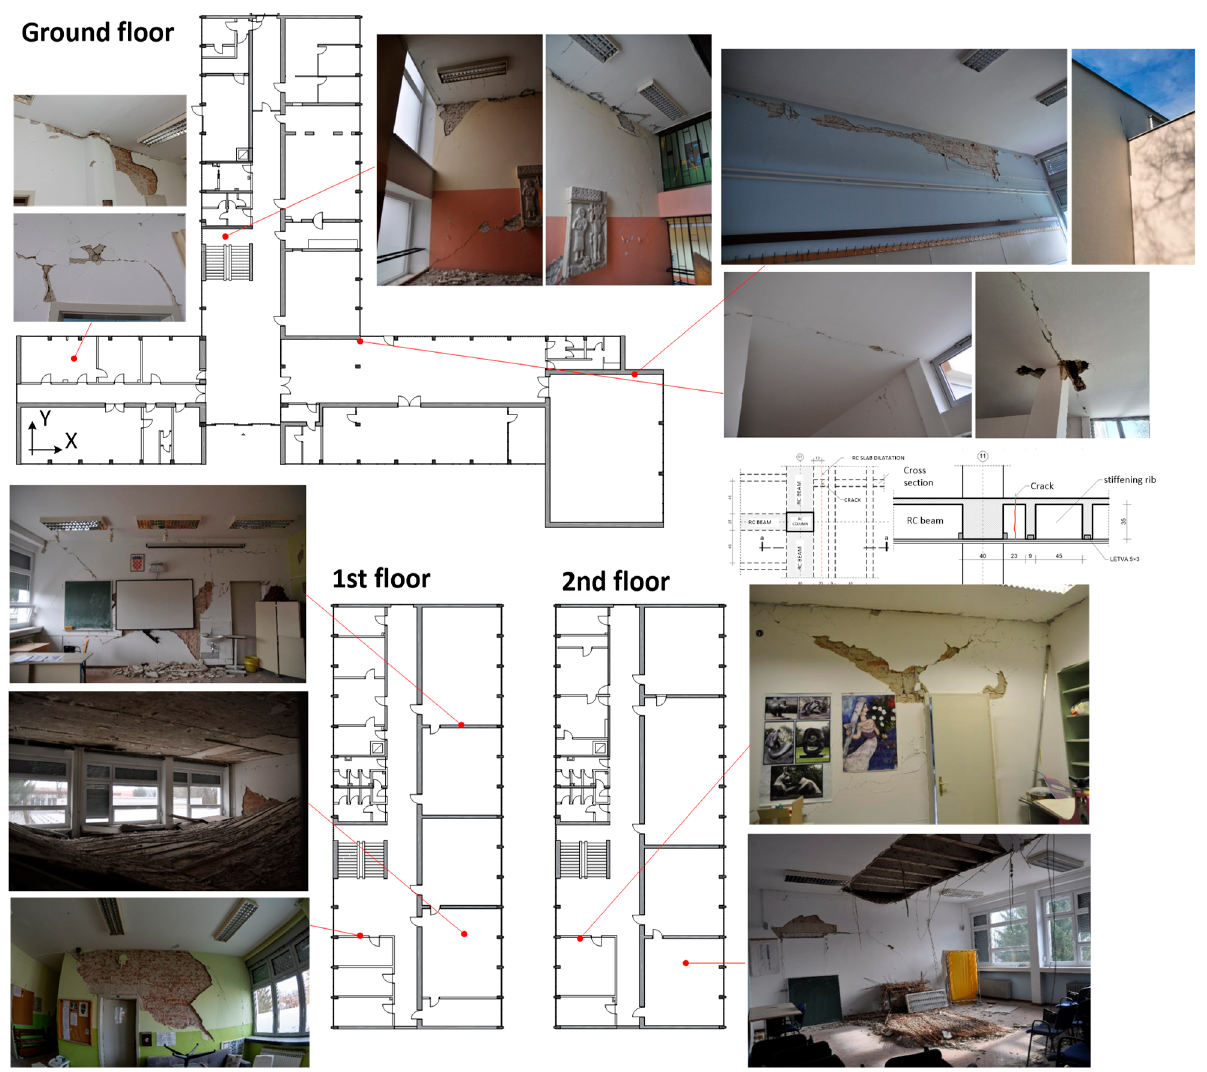
Figure 6. Photographs of damage to the building (photos: courtesy of Joško Krolo and Karlo Jandri ć , 2021; and CCEE, 2021).